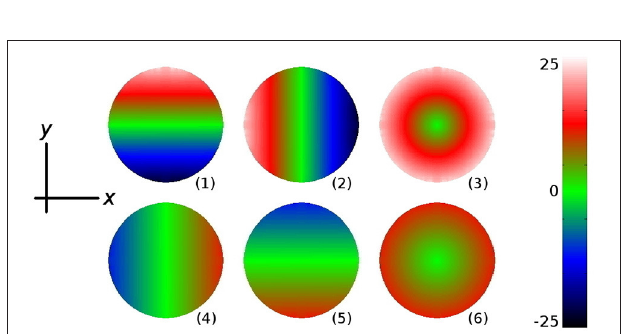
FIGURE 15 | Mid-point sections in a body subject to torsion. On the left is a square cross-section, showing the characteristic out-of-plane warping obtained for non-circular cross-sections. On the right is a circular cross-section obtained by cutting elements outside a circle inscribed within the square. Vertical displacements have been magnified by a factor of 50.